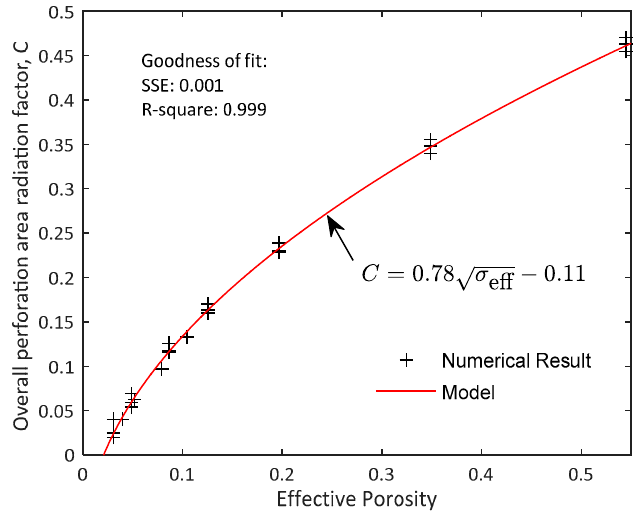
Figure 14. Proposed model for end correction factor as a function of effective porosity.